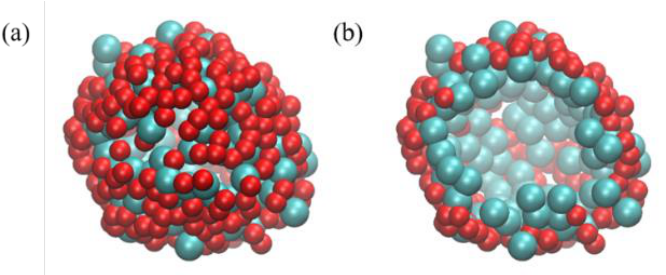
Figure 5. ( a ) All and ( b ) parts of the outermost methane and water molecules at the interface between the methane gas bubble and the surrounding solution. Methane molecules are represented by cyan balls, oxygen atoms are shown in red balls, and hydrogen atoms are hidden.